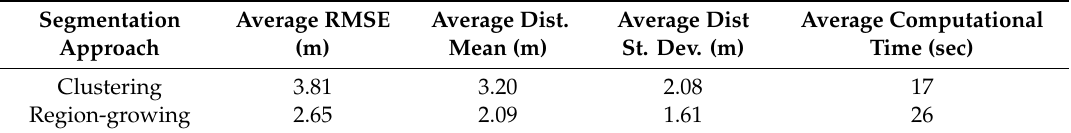
Figure 5. Results of 3d buildings reconstruction over downtown Toronto (Canada) using ( a ) the clustering roof segmentation approach and ( b ) the region growing approach. Table 1. Average performances of the geometry accuracy on the 58 buildings over downtown Toronto (Canada) of each of the two segmentation approaches compared with the reference data.